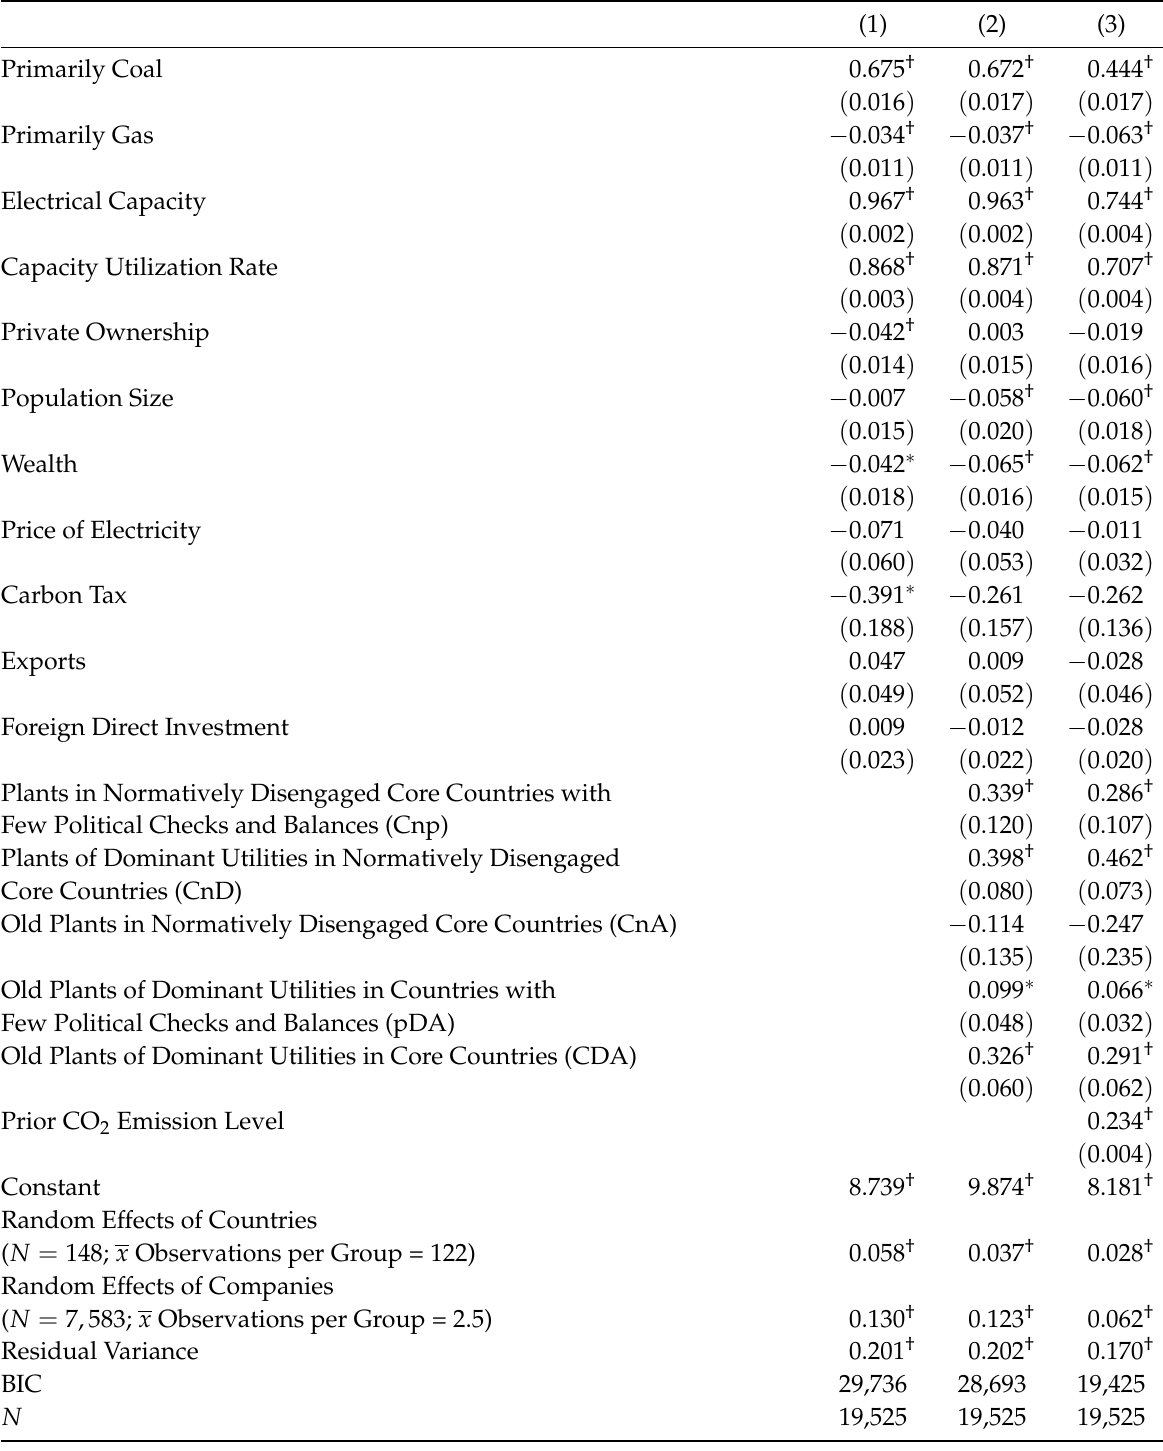
Table 8: Regression analysis of the effects of configurations on power plants’ CO